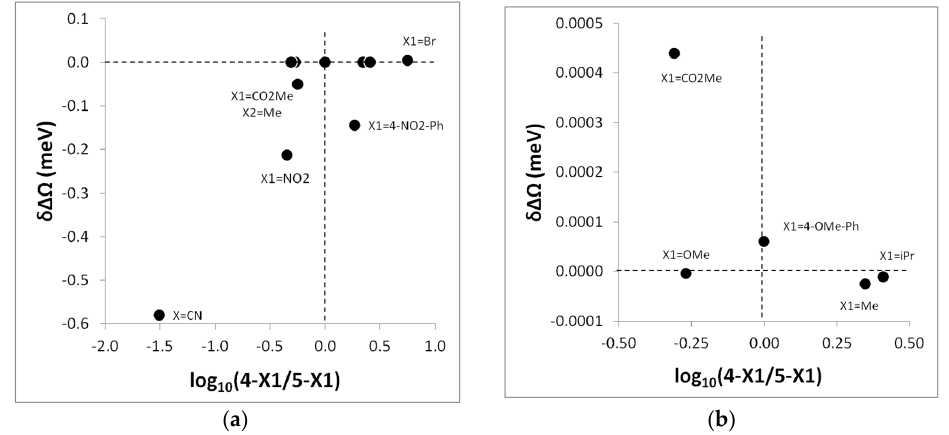
Figure 2. Plot of the grand potential stabilization difference δΔΩ = ΔΩ (5-X) − ΔΩ (4-X) vs. the logarithm of the regioisomeric product ratio log 10 (4-X 1 :5-X 1 ) for the 1,3-DC of diphenyl nitrilimine 6 with 1,2-disubstitued ethenes and acrylonitrile (X 1 = CN). Panel ( b ) is an enlargement of panel ( a ) near the origin of the co-ordinate axes. When not specified, X 2 = Ph is intended.